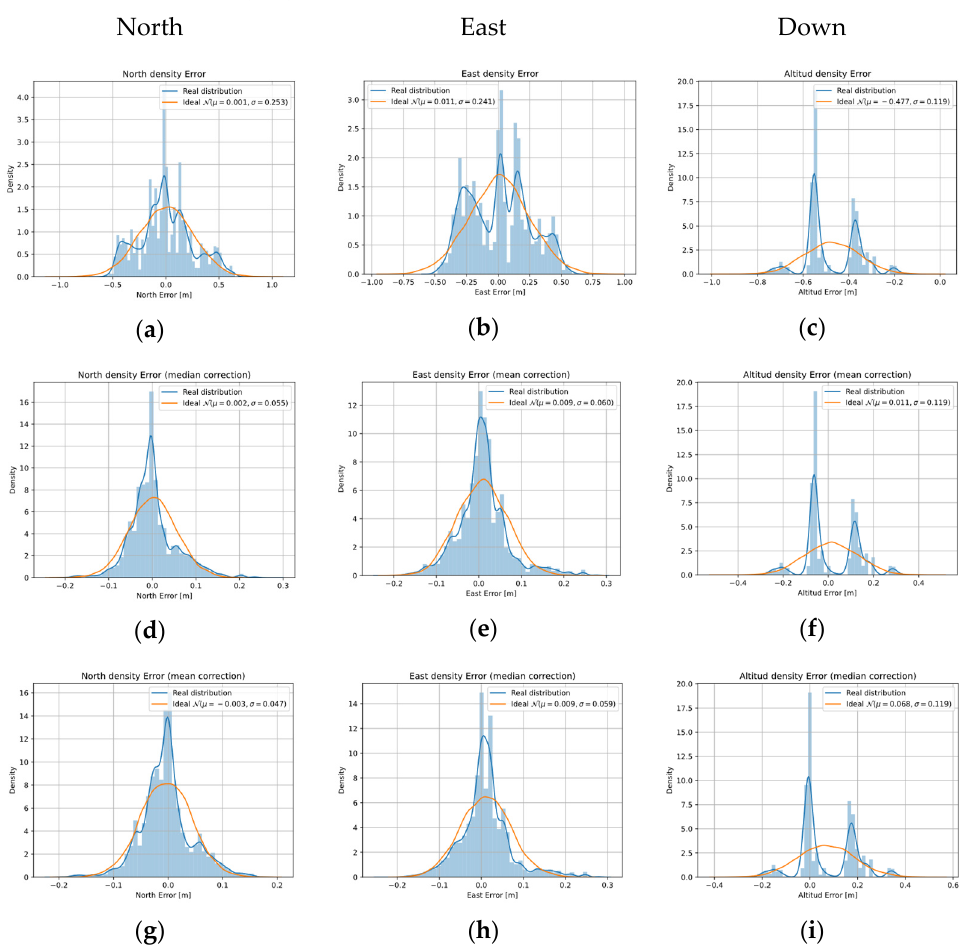
Figure 13. NED coordinates density error distribution. North-East-Down data without correction ( a , b , g ). Data with mean cylindrical correction ( c , d , h ). Data with median cylindrical correction ( e , f , i